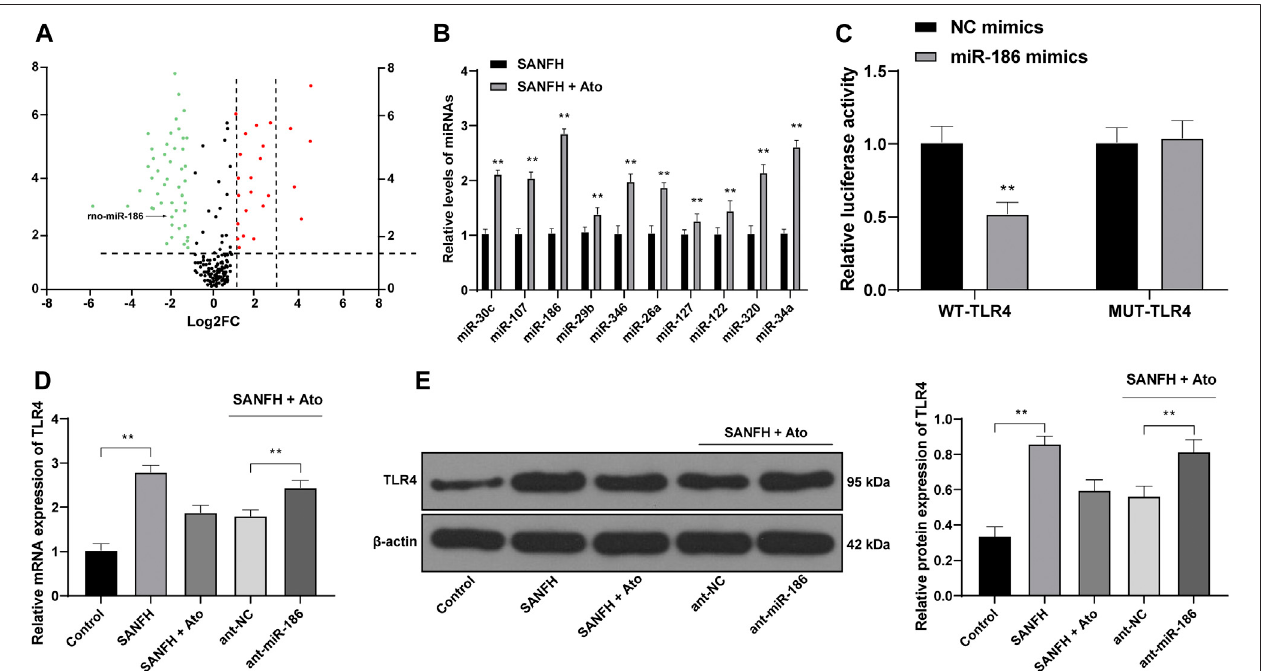
FIGURE 2 | miR-186 is upregulated in Ato-treated SANFH rats and targets TLR4. (A) The differentially expressed miRs in the femoral head of rats in the SANFH + Ato group were analyzed by microarray; each point represents a miR; green represents the downregulated miR in the femoral head of SANFH rats after Ato treatment, and red represents the upregulated miR; (B) 10 miRs with high expression in SANFH + Ato rats were selected and further veri fi ed by RT-qPCR; (C) bioinformatics predicted there was a speci fi c binding site between miR-186 and TLR4, and the target binding relationship was proven by the dual luciferase reporter gene assay; (D,E) levels of TLR4 mRNA and protein after inhibiting miR-186 expression were detected by RT-qPCR and Western blot analysis. n (cid:1) 6 in each group. The data are shown in mean ± standard deviation. ** p < 0.01 vs. control group, or SANFH